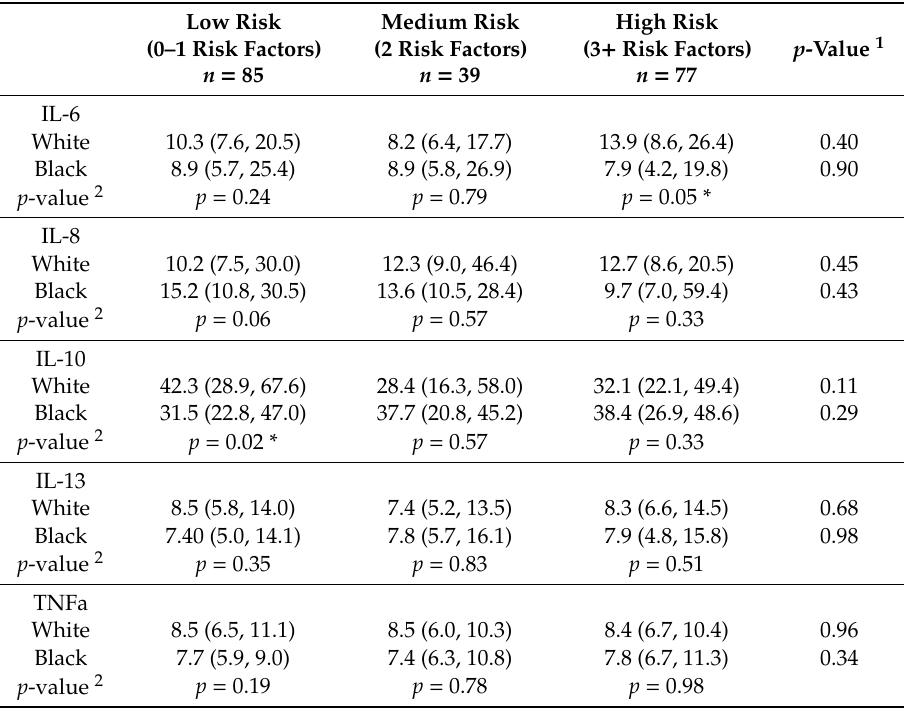
Table 7. Median cytokine levels stratified by risk and race.